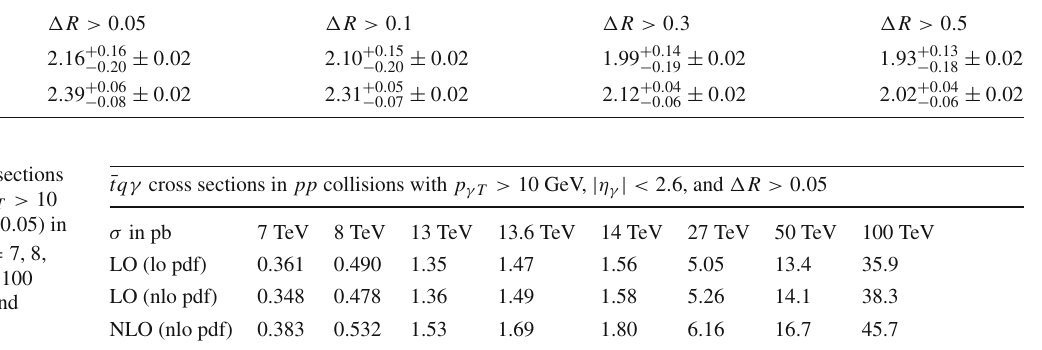
Table 5 The tq γ cross sections at LO and NLO (in pb, with central value for μ = m t with scale and pdf uncertainties, and using cuts (cid:7) R > 0 . 05, 0.1, 0.3, and 0.5, as well as p γ T > 10 GeV and | η γ | < 2 . 6) in pp collisions with tq γ cross sections at 13.6 TeV LHC energy with p γ T > 10 GeV and | η γ | < 2 . 6